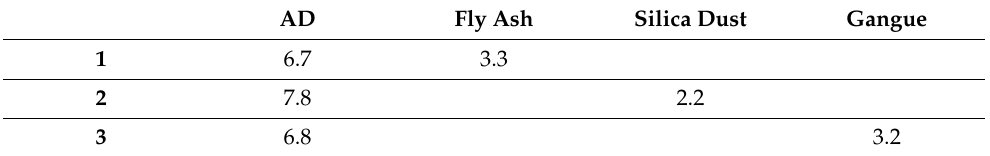
Figure 1. XRD of raw materials: ( a ) AD; ( b ) Fly ash; ( c ) Silica dust; ( d ) Gangue. Table 2. The ratio of different samples (mass,